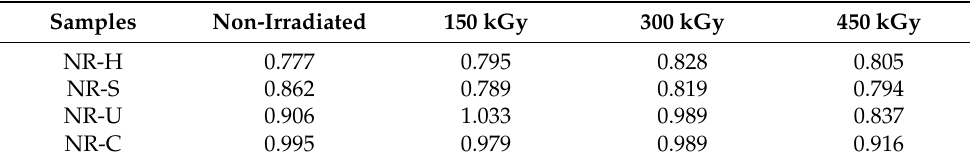
Table 5. The values of composites V ro / V rf ratio determined in toluene.